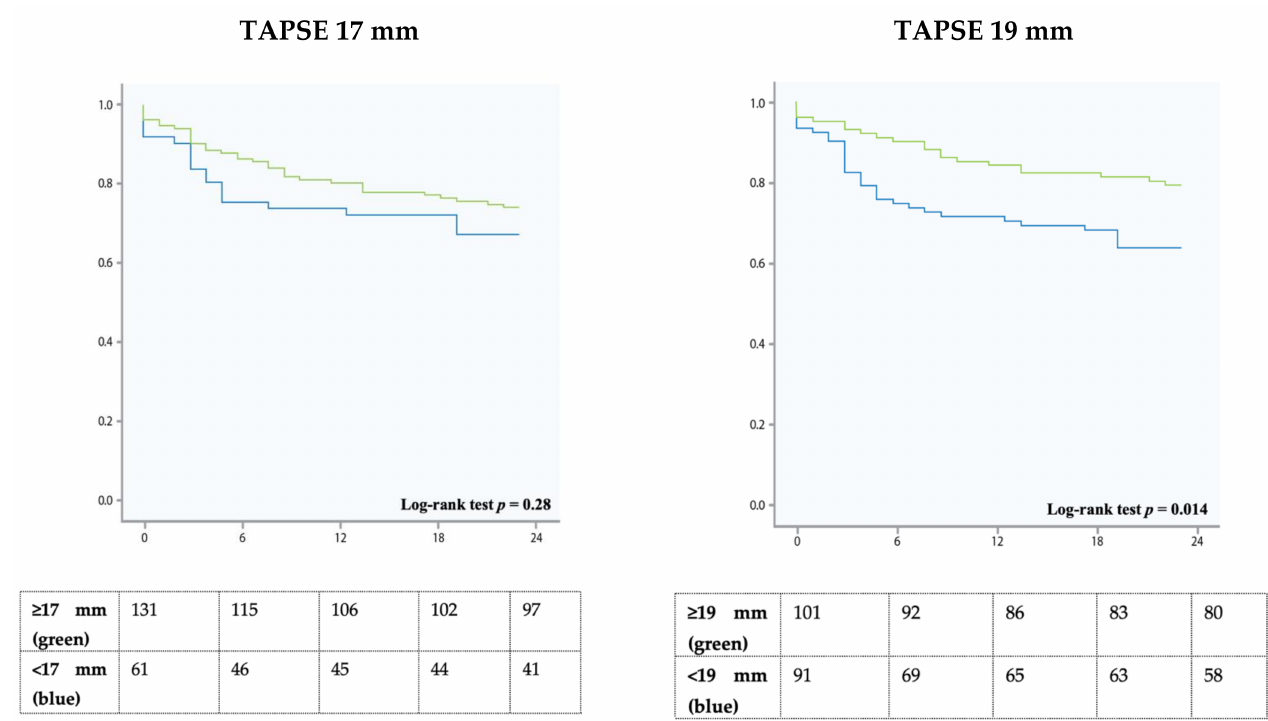
Figure 1. Kaplan Meier survival analysis showing 2-year survival of patients with tricuspid annular plane systolic excursion (TAPSE) cutoffs 17 mm and 19 mm (right). The green line indicates higher values ( ≥ 17 mm on the left, ≥ 19 mm on the right), the blue line indicates lower values (<17 mm on the left, <19 mm on the